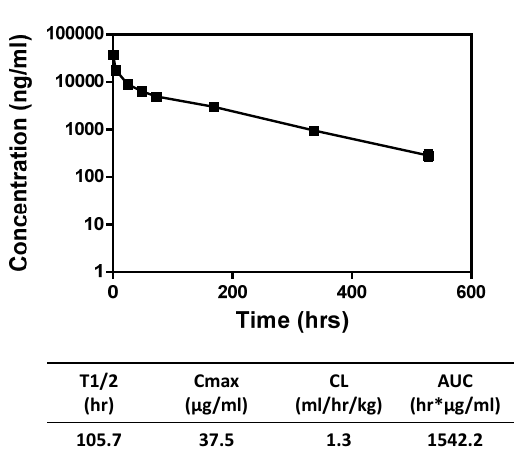
Figure 8. P ‐ cadherin LP ‐ DART serum concentrations following a single 2 mg/kg IV bolus are plotted (upper panel); the maximum observed concentration (C max ), area under the concentration curve to the last quantifiable concentration (area under the curve or AUC), predicted total body clearance (CL), and terminal half ‐ life (T 1/2 ) determined by Non Compartment Analysis using WinNonlin are tabulated below. The DART molecule without the Fc domain was not tested in this study. However, previous studies of unrelated DART proteins in several strains of mice have shown rapid clearance, with T 1/2 values ranging from 2.4 to 3.6 h [16].